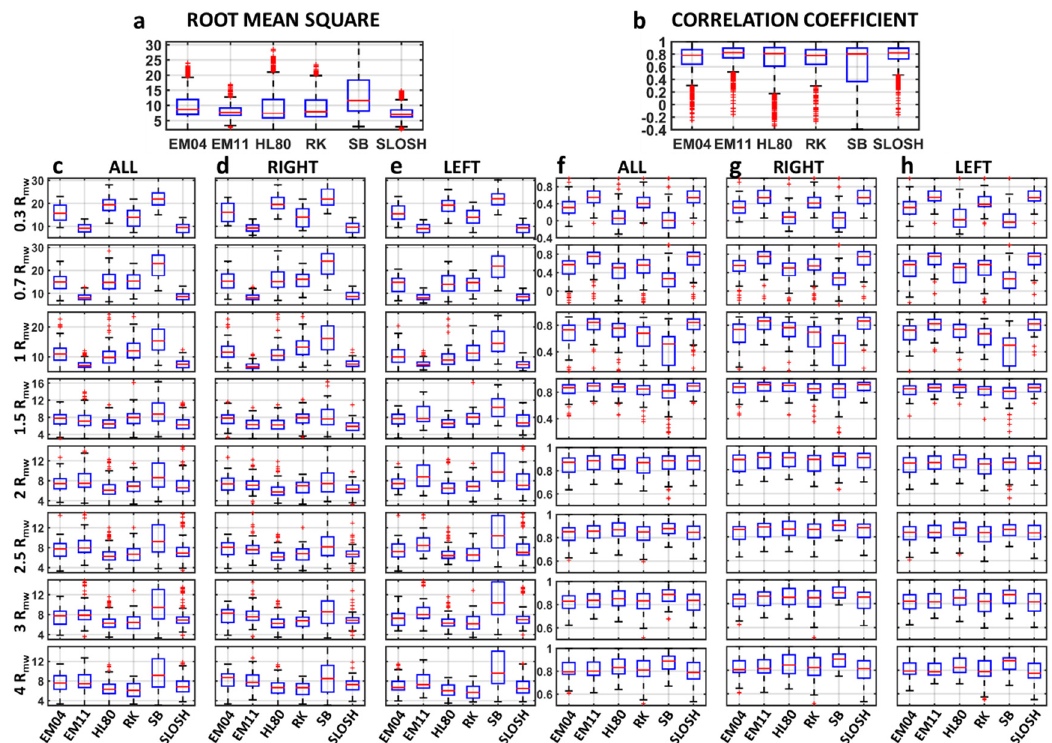
Figure5. Root-mean-squareerror(RMS)andcorrelationcoe ffi cient(CC)boxplotwindspeedcomparison Figure 5. Root-mean-square error (RMS) and correlation coefficient (CC) boxplot wind speed between time series of H*Wind and parametric models ( a , b in top panels) and at normalized locations comparison between time series of H*Wind and parametric models ( a,b in top panels) and at (each 22.5 ◦ clockwise from HURDAT2 TC trajectory and at di ff erent distances from the storm center, 0.3, normalized locations (each 22.5° clockwise from HURDAT2 TC trajectory and at different distances 0.7, 1, 1.5, 2, 2.5, 3 and 4 * R mw in each time step) for all (ALL) ( c , f ), right (RIGHT) ( d , g ), and left (LEFT) from the storm center, 0.3, 0.7, 1, 1.5, 2, 2.5, 3 and 4 * R mw in each time step) for all (ALL) ( c,f ), right ( e , h ) quadrants. Time series represents all the time steps with H*Wind data. Each box represents the 25th percentile (bottom) and 75th percentile (top) bounding the median (middle line), the wider dash lines represent the 10th percentile (bottom) and 90th percentile (top), and red points represent above 90th